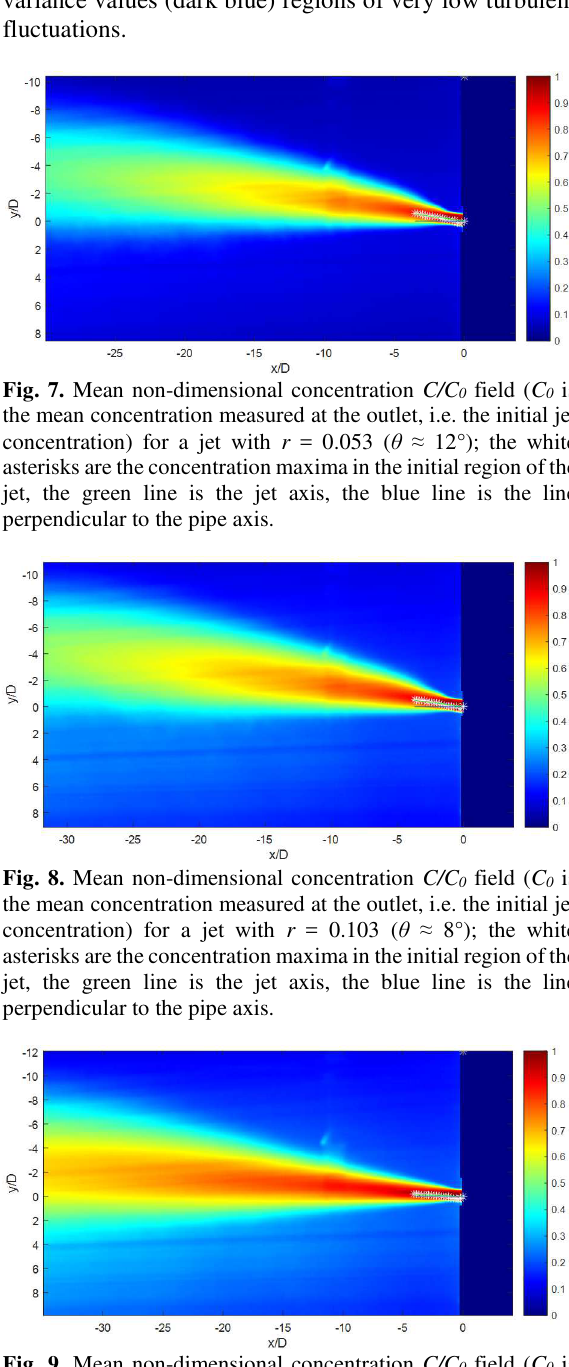
Fig. 9. Mean non-dimensional concentration C/C 0 field ( C 0 is the mean concentration measured at the outlet, i.e. the initial jet concentration) for a jet with r = 0.482 ( θ ≈ 2°); the white asterisks are the concentration maxima in the initial region of the jet, the green line is the jet axis, the blue line is the line perpendicular to the pipe axis.